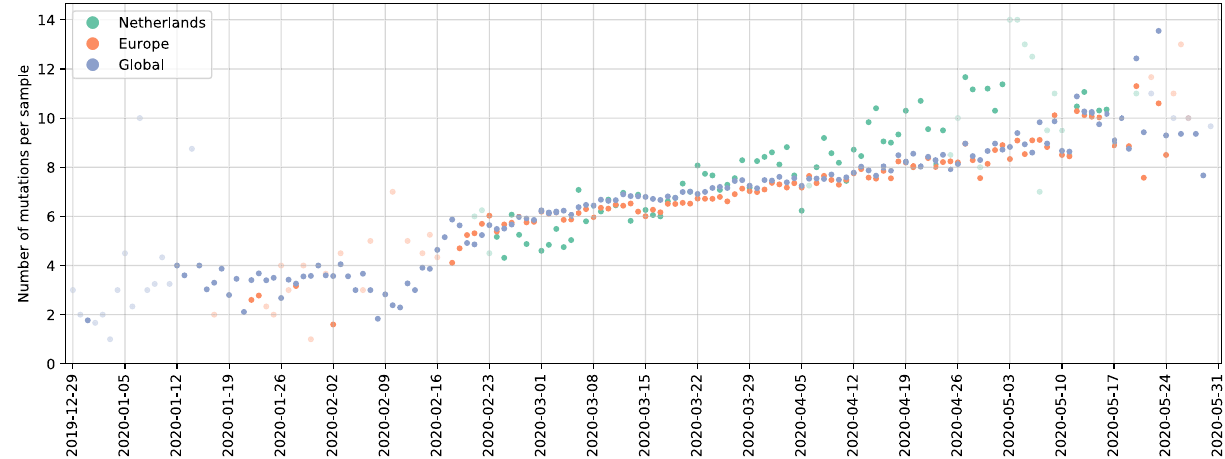
Figure 3. Number of mutations per sample per day over the course of pandemic in the Netherlands (green), Europe (orange) and globally (blue): each point is the average number of mutations observed in samples collected on the same date in the Netherlands (green), Europe (orange) and globally (blue), x-axis shows collection date. Data points corresponding to days with fewer than five samples are colored transparently to indicate uncertainty.